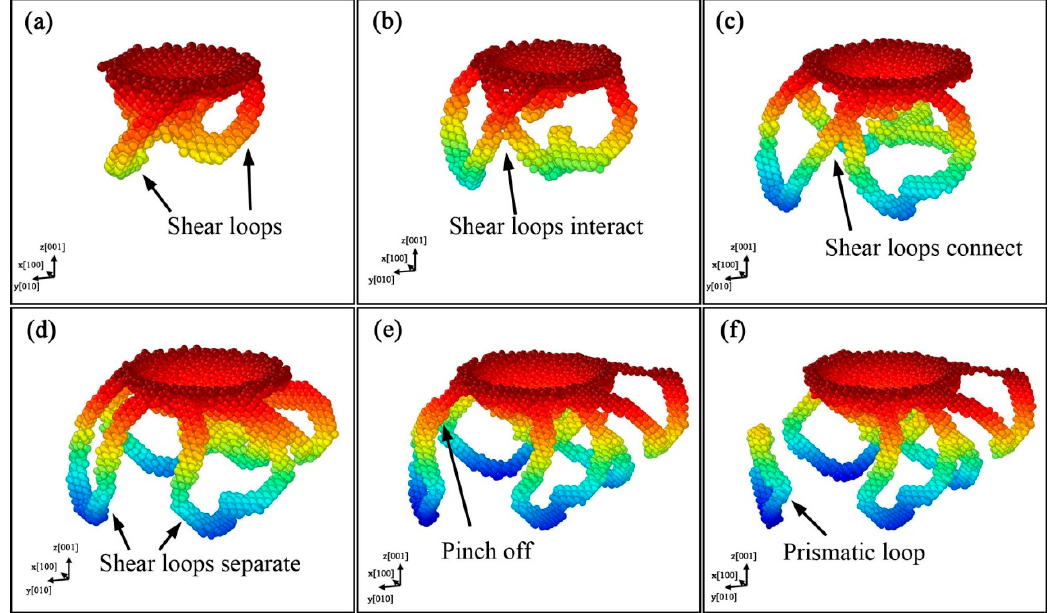
Figure 11. Formation of prismatic loops based on “lasso”-like mechanism for indentation on (001) plane, with colors representing depth from sample surface. The evolution process is illustrated on each subfigure from ( a – f ).